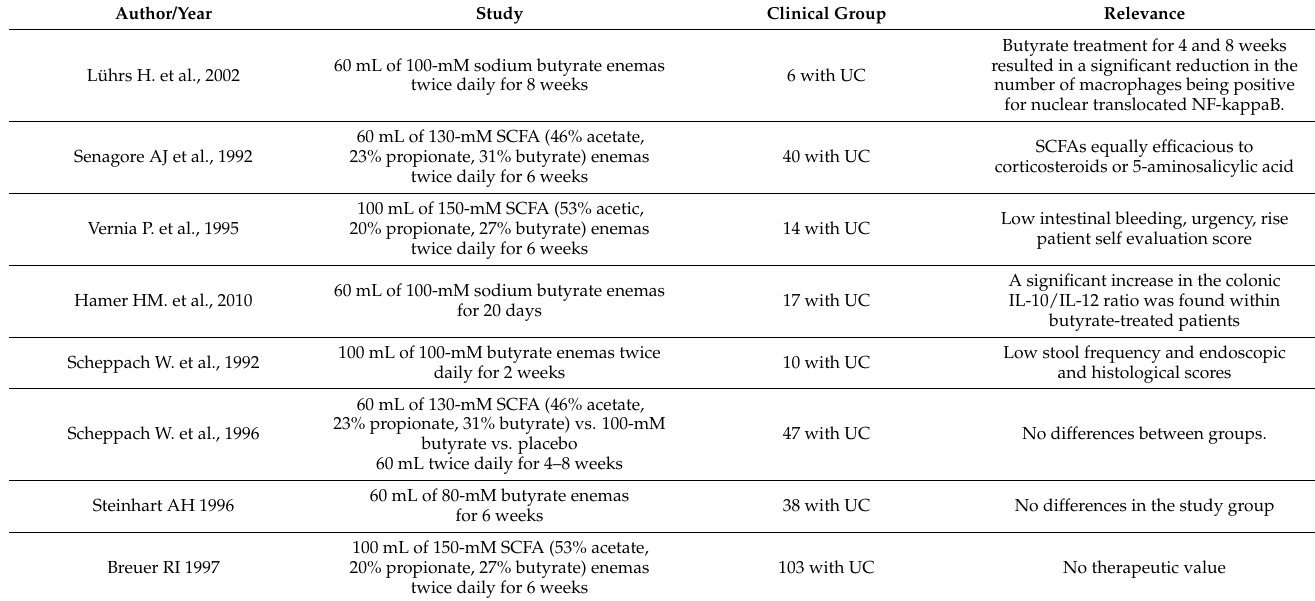
Table 4. SCFAs in the treatment of